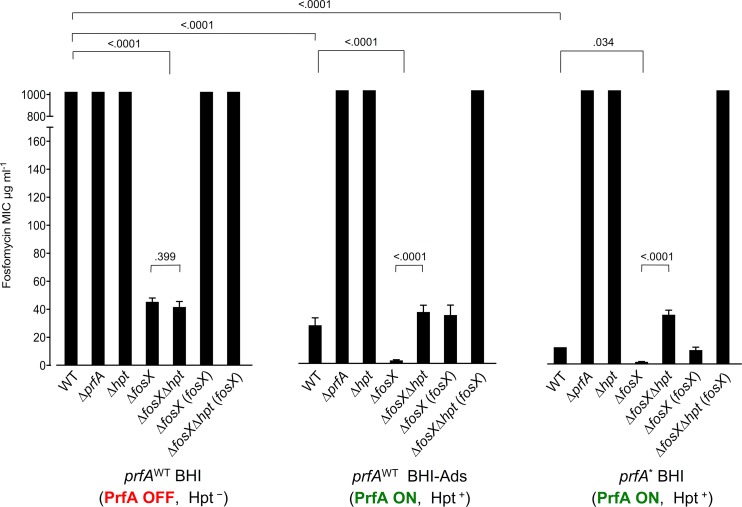
Genetic analysis of the role of fosX, prfA and hpt in L. monocytogenes fosfomycin phenotype.MIC, minimal inhibitory concentration. Mean ± SD from at least three independent experiments. Relevant P values are indicated (one-way ANOVA with uncorrected Fisher’s post-hoc multiple comparisons). Left panel: wild-type prfA allele (WT) in BHI medium (virulence-resting conditions i.e. PrfA system “Off”, Hpt not expressed). Middle panel: WT in charcoal-supplemented BHI (BHI-Ads; virulence-activating conditions i.e. PrfA system “On”, Hpt expressed). Right panel: constitutively activated prfA* allele in BHI (in vivo-like virulence-activating conditions i.e. PrfA locked “On”, Hpt expressed). See S2 Table for bacterial constructs. Note: (i) in in vitro (outside host) conditions (left panel), deletion of fosX renders L. monocytogenes susceptible to fosfomycin (drop in MIC from ≥1,024 to 45.3 μg/ml; susceptibility breakpoint = 64 μg/ml [18]); (ii) in infection-like conditions (middle and right panels), the activation of the PrfA system and ensuing increased influx of fosfomycin via the PrfA-regulated organophosphate transporter Hpt overrides fosX-mediated resistance and L. monocytogenes becomes susceptible to fosfomycin (MICs between 12.0 and 27.3 μg/ml).